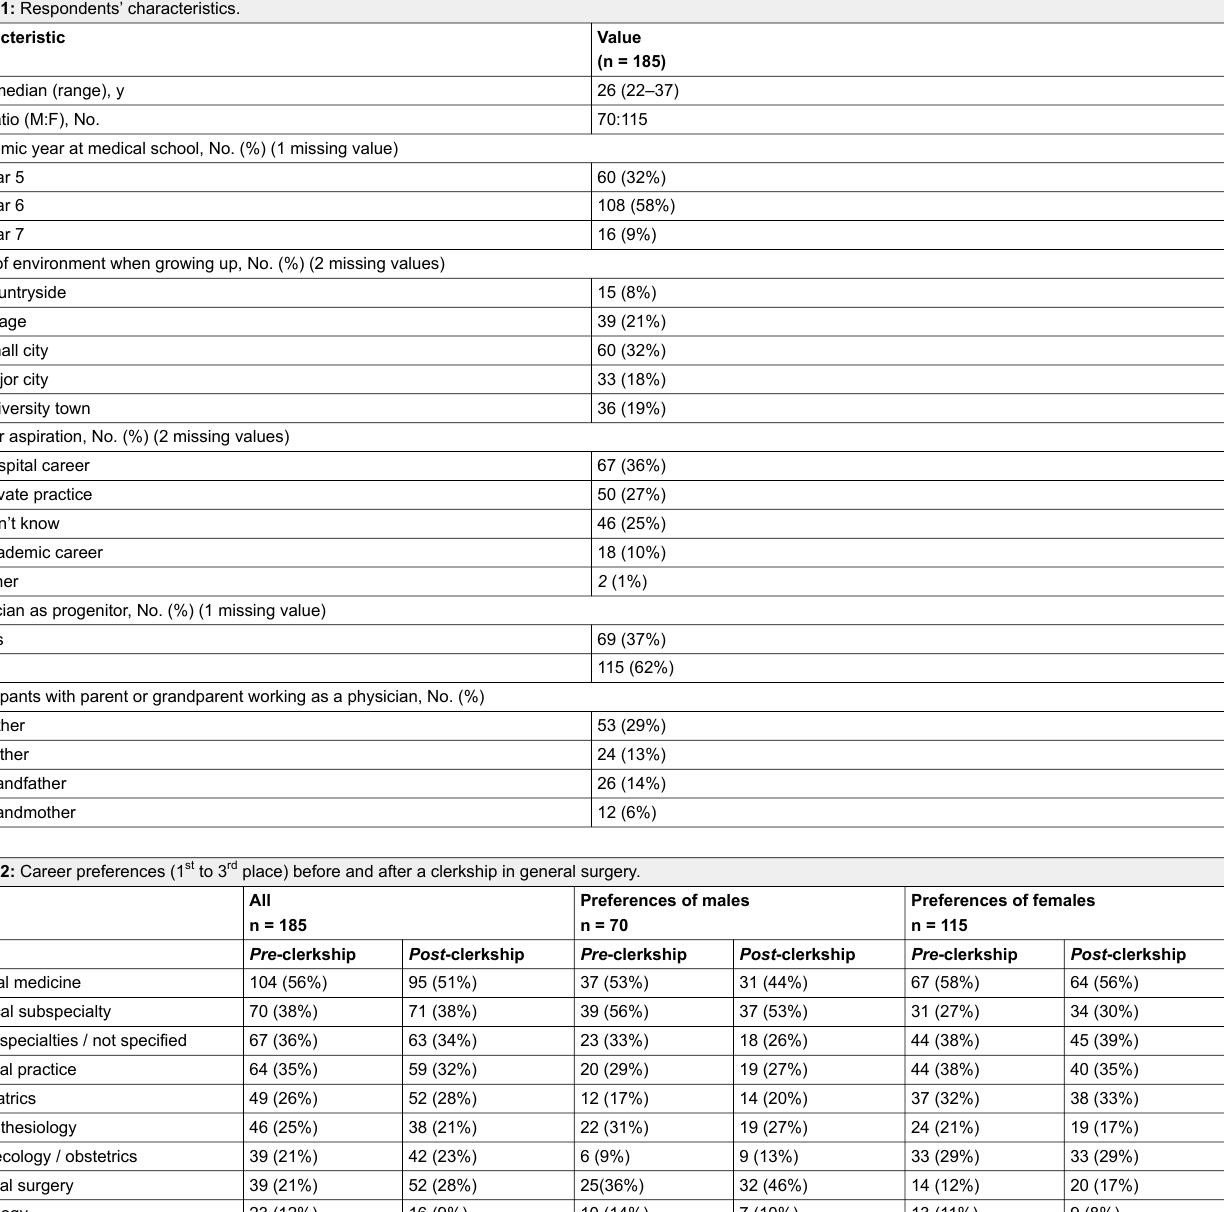
Table 1: Respondents’ characteristics.